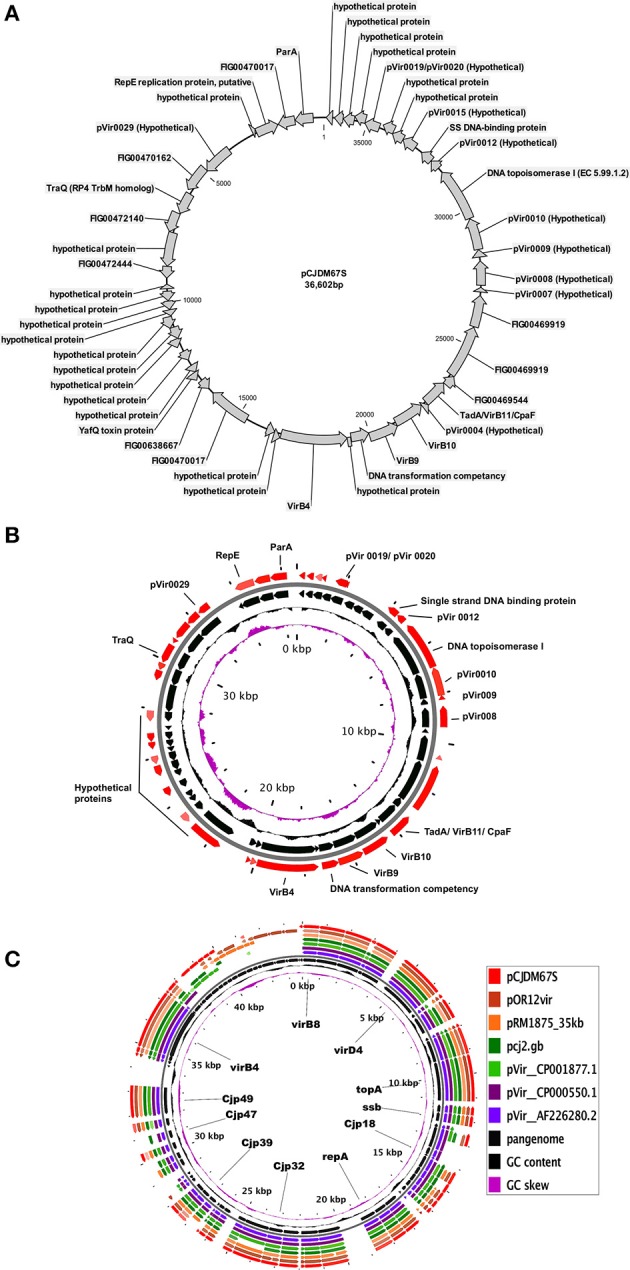
(A) Circular map of the plasmid, pCJDM67S, (B) core genome of pVir plasmids (Red arrows in outer circle represent core genome), and (C) pangenome of all pVir plasmids used in study.